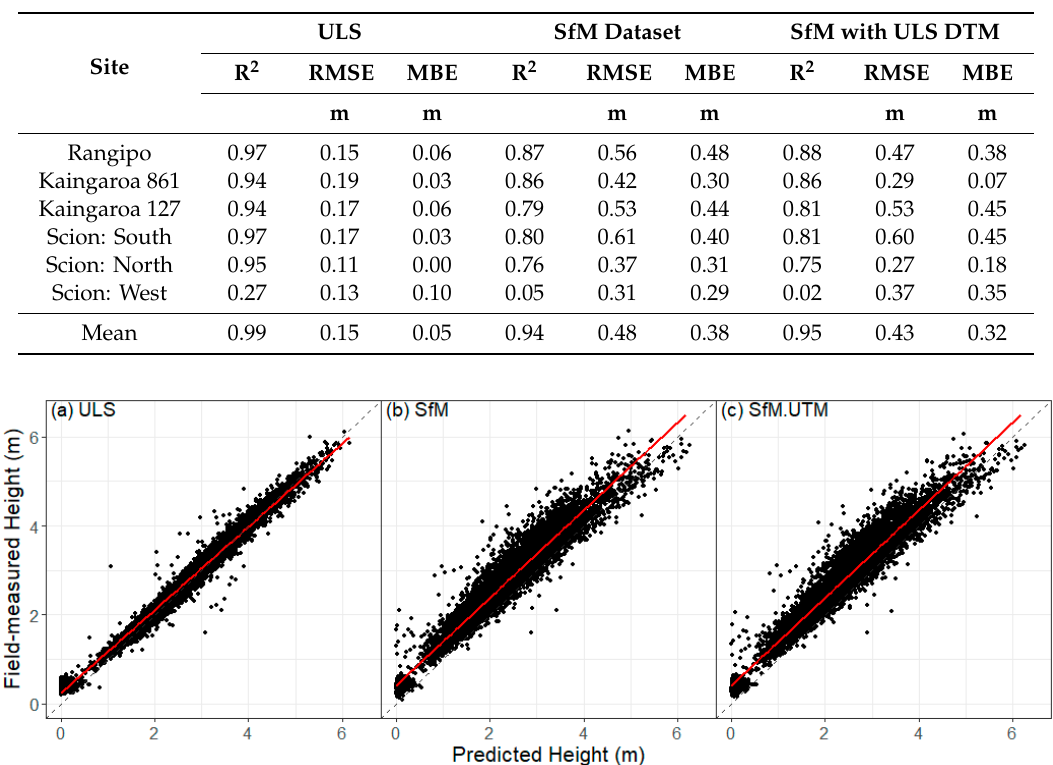
Figure 4. Correlation between field-measured tree heights and heights predicted from ( a ) ULS, ( b ) SfM and ( c ) SFM UTM . The 1:1 line is shown as a dashed black line and a linear model fitted through the data is shown as a solid red line.